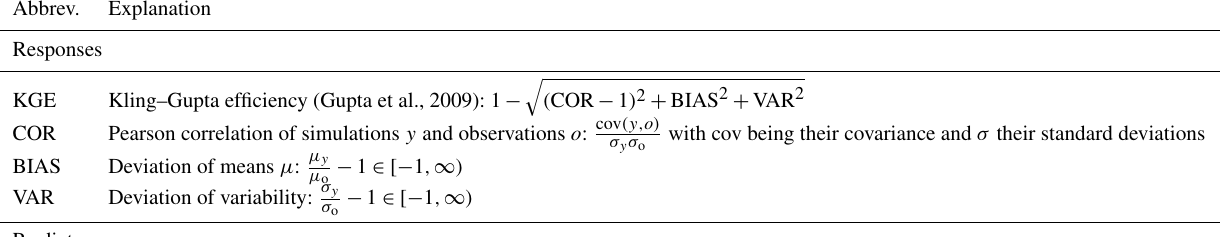
Table 1. Response and predictor variables used for the analyses of the process-based model performance.